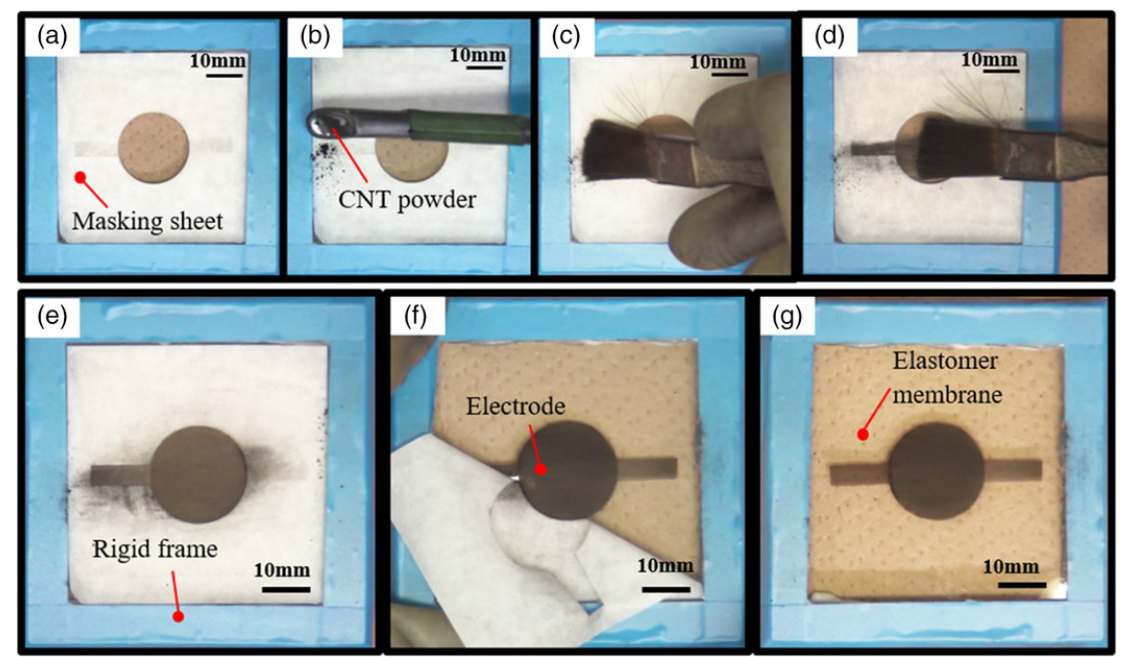
Figure 22. Brushing method for the stretchable electrode and the fabrication method for a single-layer DEA, ( a ) shows the first step of laying down the 10 mm square piece of masking sheet that has a hole in the middle of it which is the exposed desired part of the elastomer membrane that will be worked on. ( b ) shows the pouring of the CNT powder, and ( c ) shows the use of a brush to prep for spreading the CNT powder across the hole onto the bare elastomer membrane within the hole of the masking sheet. ( d ) shows the further spreading of the CNT powder across the exposed portion of the elastomer membrane within the masking sheet enough to create a thin layer of CNT across the whole exposed area. ( e , f ) shows them then pulling off the masking sheet to show the now created concentrated CNT powdered portion now considered an electrode. ( g ) shows the now formed electrode as result of this concentrated CNT powder on this specific portion of the elastomer membrane (Reprinted with permission from Wiranata, A., et al. [157]. Copyright 2021, CC BY NC ND 4.0 International).